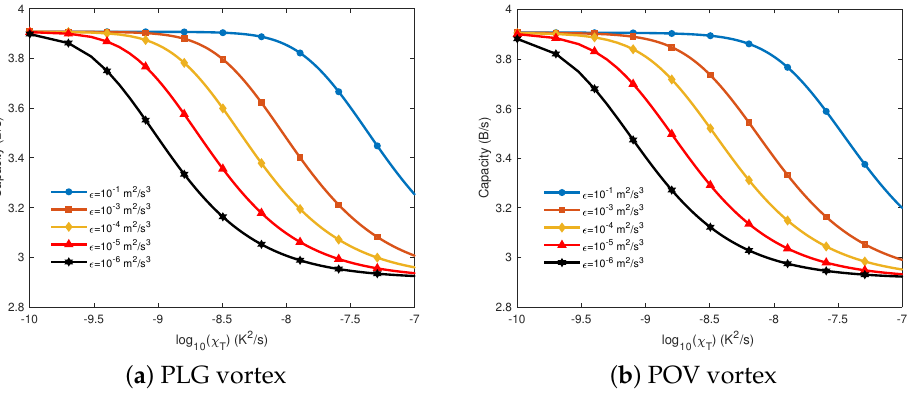
Figure 2. Information capacity of OAM channels with the carriers of PLG vortex and POV vortex versus dissipation rate of the mean-squared temperature χ T and dissipation rate of kinetic energy per unit mass of fluid ε